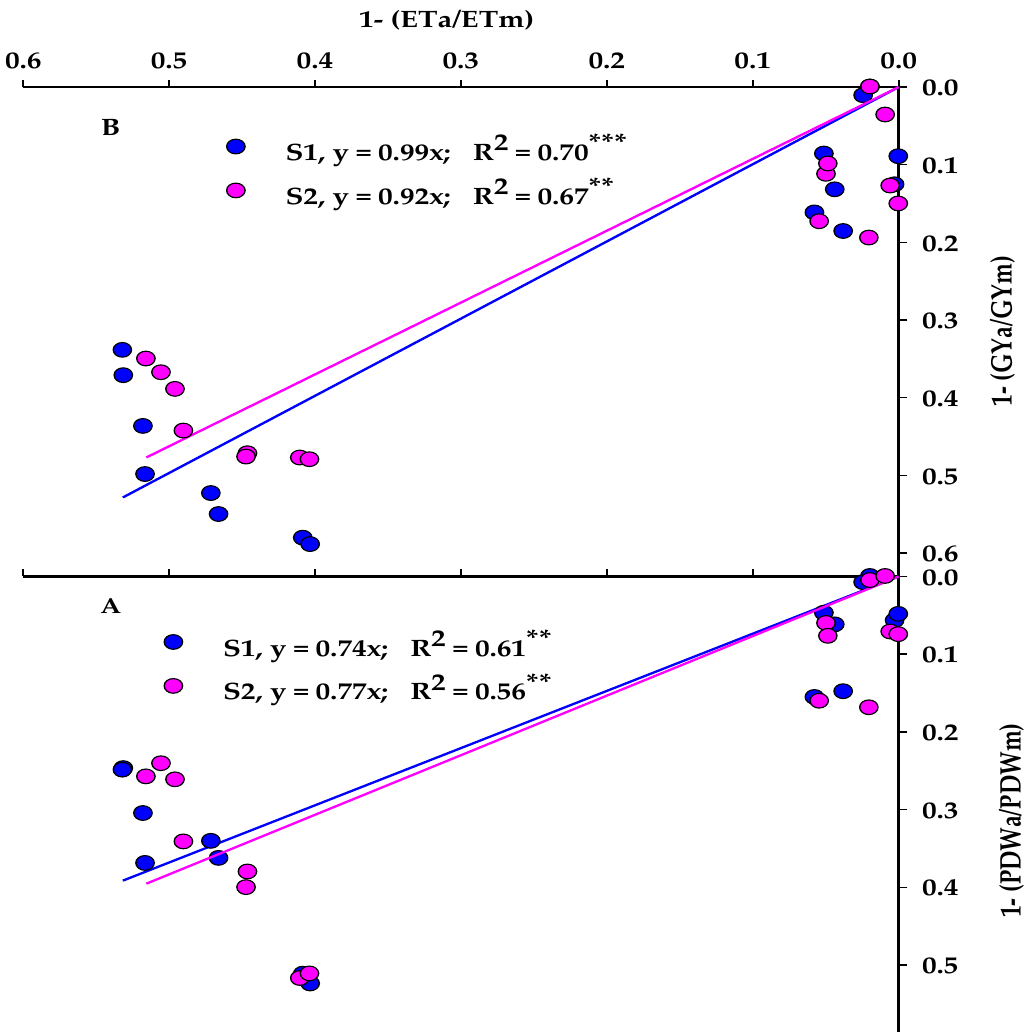
Figure 7. Yield response factor (ky) shown as the relationship between the relative plant dry weight decrease PDW ( A ) or grain yield decrease GY ( B ) and the corresponding relative evapotranspiration (ET) decrease for first season (S1) and second season (S2). **, and *** indicate significant at p < 0.01 and 0.001, respectively.